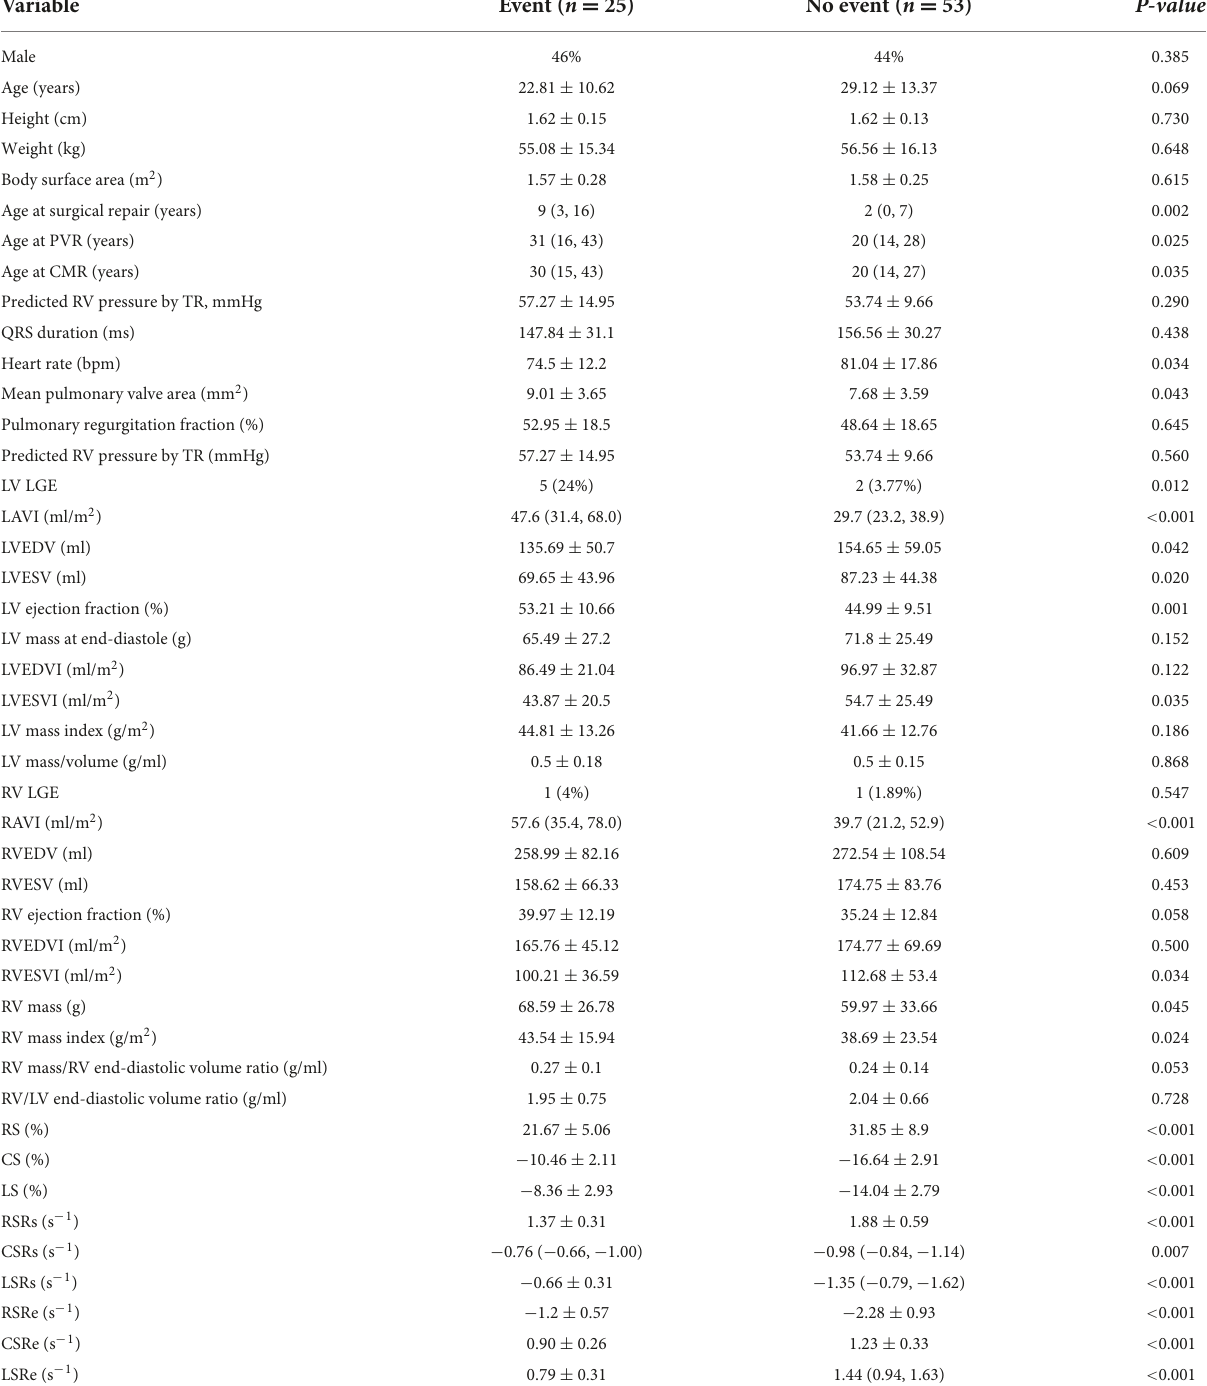
TABLE 2 Comparison of baseline parameters and LV strain parameters (mean ± SD/median and interquartile range) between patients with or without adverse events.